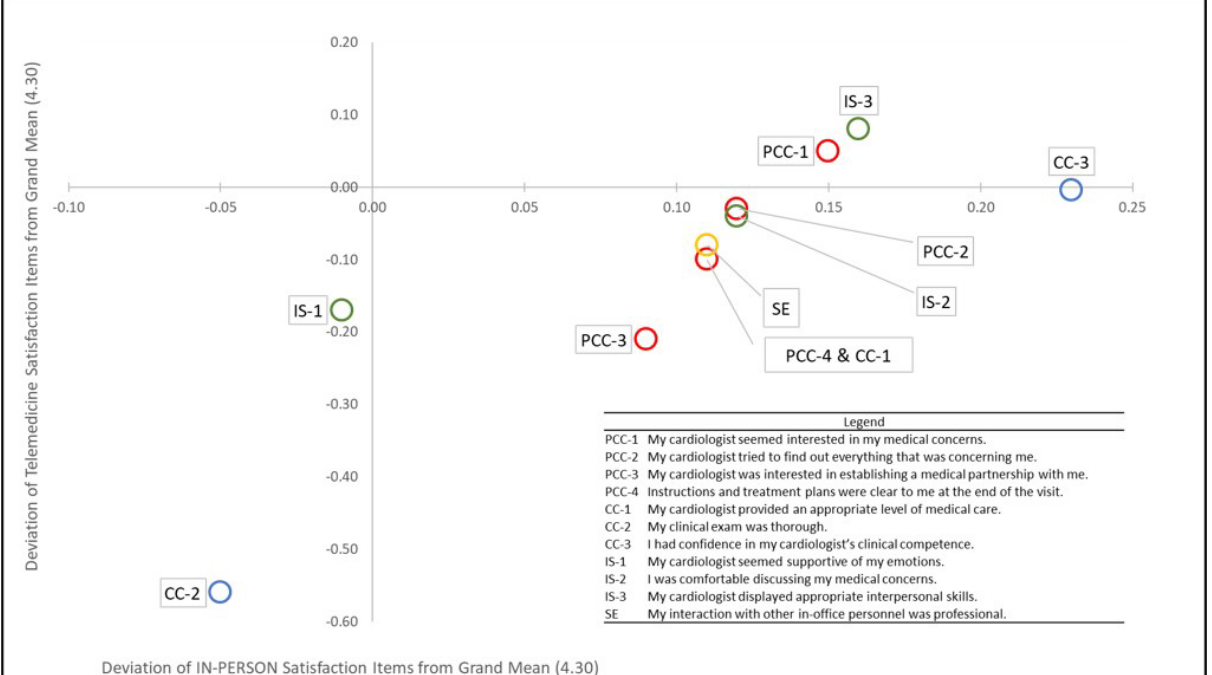
Figure 1. Changes in satisfaction ratings for individual survey items between telehealth and in-person. Points are expressed as the deviation of the mean of individual survey items from the grand mean of 4.30 for in-person (horizontal axis) and telehealth experiences (vertical axis). Labels reflect the survey domain and item number as indicated in Table 2. Points above and/or to the right of their respective axis indicate items whose mean rating was above the grand mean of all items, while those to the left and/or below indicate points with ratings below the grand mean. The lower right quadrant contains items for which in-person mean ratings were above the grand mean, while in telehealth were below the grand mean. CC: clinical competence; IS: interpersonal skills; PCC: patient-centered communication; SE: supportive